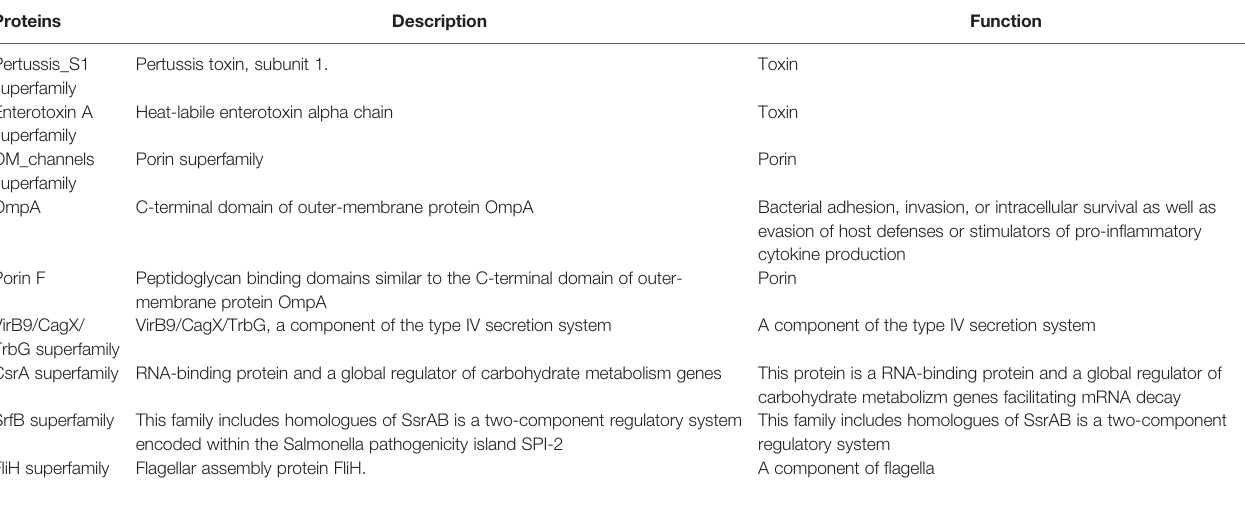
TABLE 3 | Major virulence-related proteins described in membrane vesicles of P. salmonis strain type